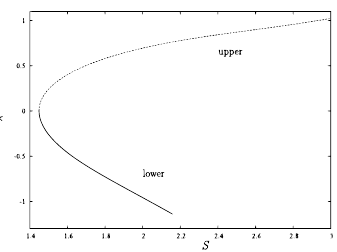
Figure 10. Temporal stability: a plot of the eigenvalue λ against S for γ = − 1 . 0, solution stable where λ < 0 (full line), unstable where λ > 0 (broken